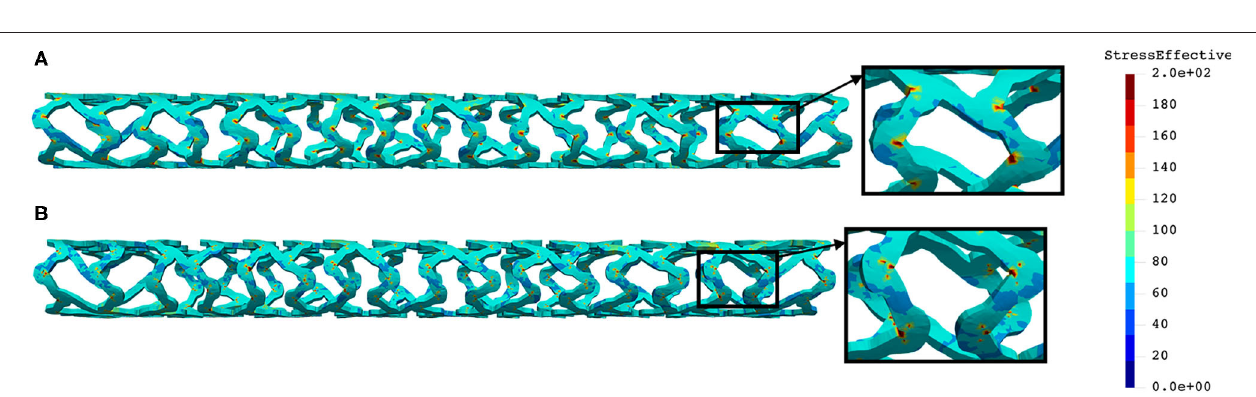
FIGURE 14 | Effective stress distribution on PLLA prot (A) and PLLA prot-slots (B) stents for crush